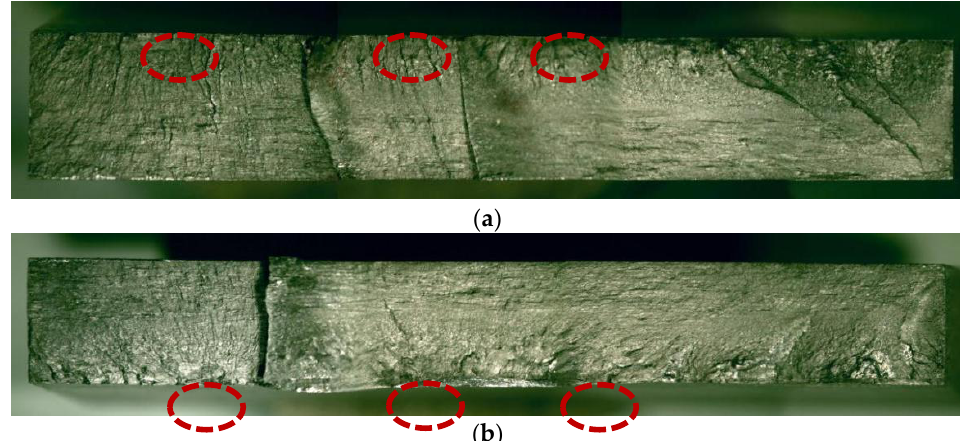
Figure 14. ( a ) Upper fracture morphology; ( b ) Lower fracture morphology.